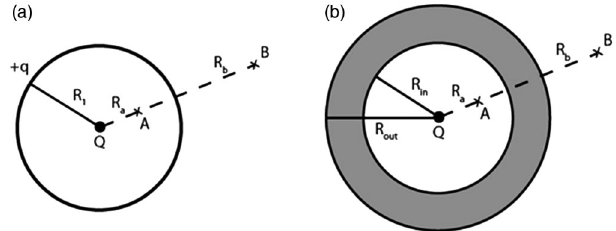
FIG. 15. Comparison between post-test problem PII-6 and example problem used in tutorial part 2. (a) Problem PII-6 involves an infinitely thin conducting shell charged with charge þ q , shown as a black circle, surrounding a point charge (black dot in the middle). (b) Example problem in part 2 of the tutorial involves a thick conducting shell (gray circular ring) surrounding the same charged particle Q